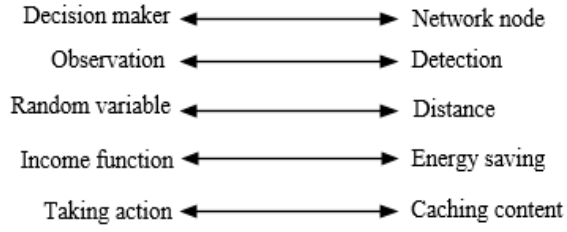
Figure 1. Optimal stopping elements in cache node selection.